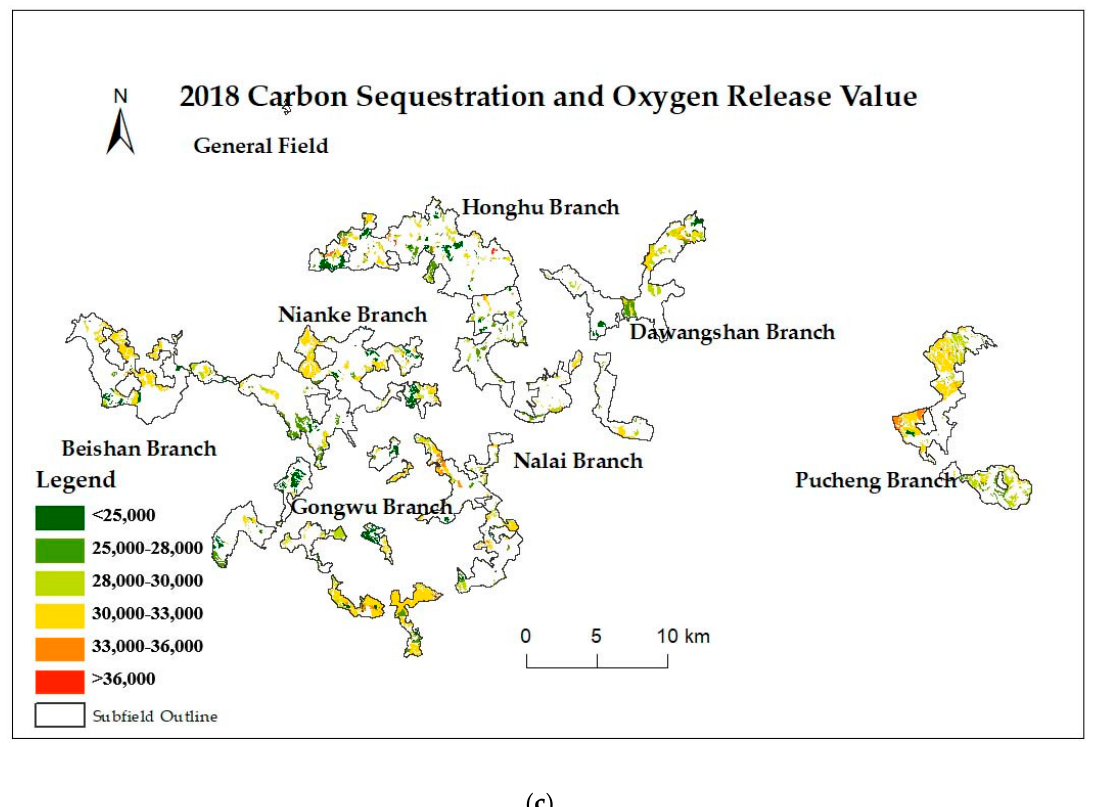
Figure 3. Spatial distribution map of the carbon sequestration and oxygen release values of PM plantations in the northern tropical case study area in 2009–2018. ( a ) 2008 Carbon sequestration and oxygen release value; ( b ) 2013 Carbon sequestration and oxygen release value; ( c ) 2018 Carbon sequestration and oxygen release value.